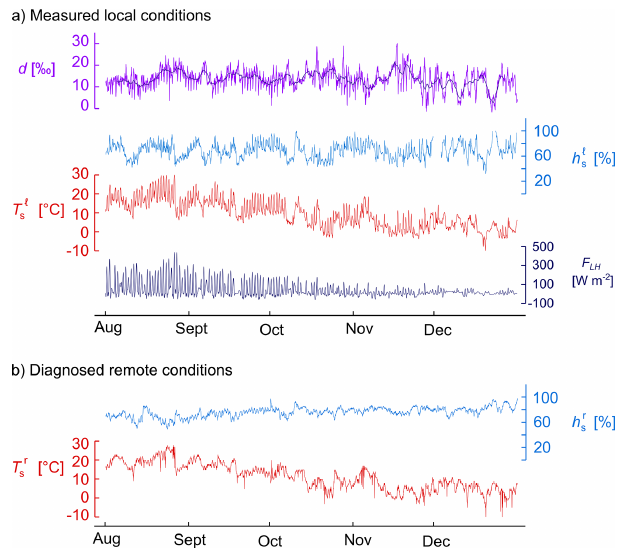
Fig. 5. (a) Time series of hourly averages of d measured in Ri- etholzbach in violet, moving average over 5days in dark blue, lo- cally measured h ‘ s , T ‘ s and latent heat flux F LH . h ‘ s for the local measurements is computed from 2m dew point measurements and normalised with respect to T ‘ s , where T ‘ s is the soil temperature 5cm below ground. (b) Time series of h r s and T r s diagnosed at the moisture source.